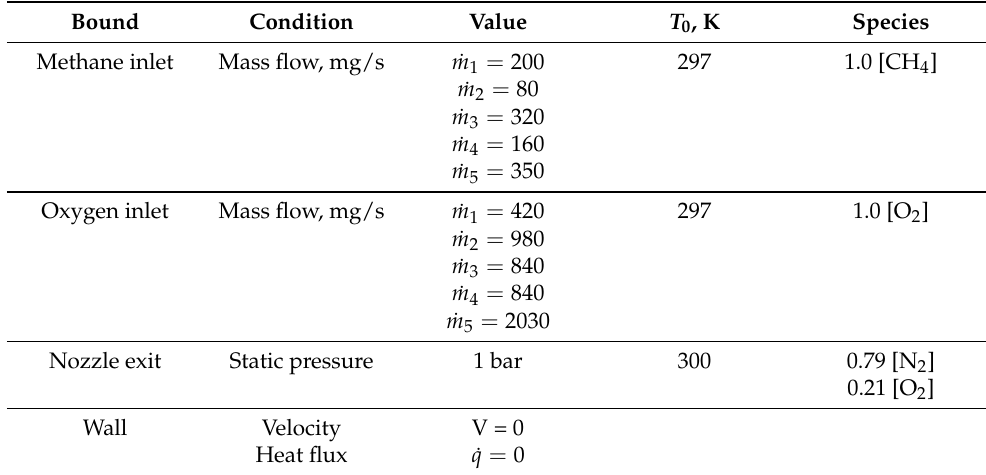
Table 2. Simulation boundary